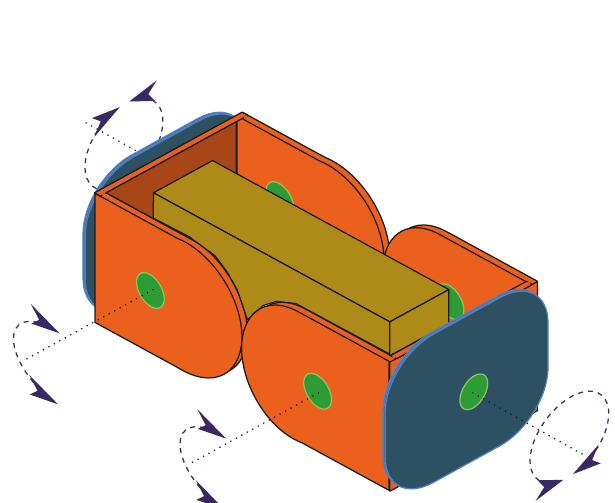
Figure 12: Model diagram of iMobot